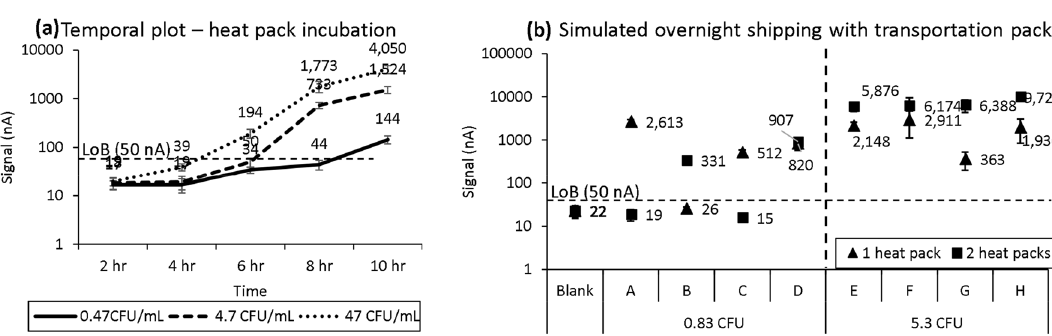
Figure 4. Simulated urine specimen shipment using the transportation pack finalized from Figs. 1 and 2. Calibration curves of urine assays including ( a ) 1 or ( b ) 2 h of viability culture. ( c ) Thermal tracking profile for transportation package used for experiment. Each error bar represents 8–15 data points; limit of blank (LoB) shown for reference.